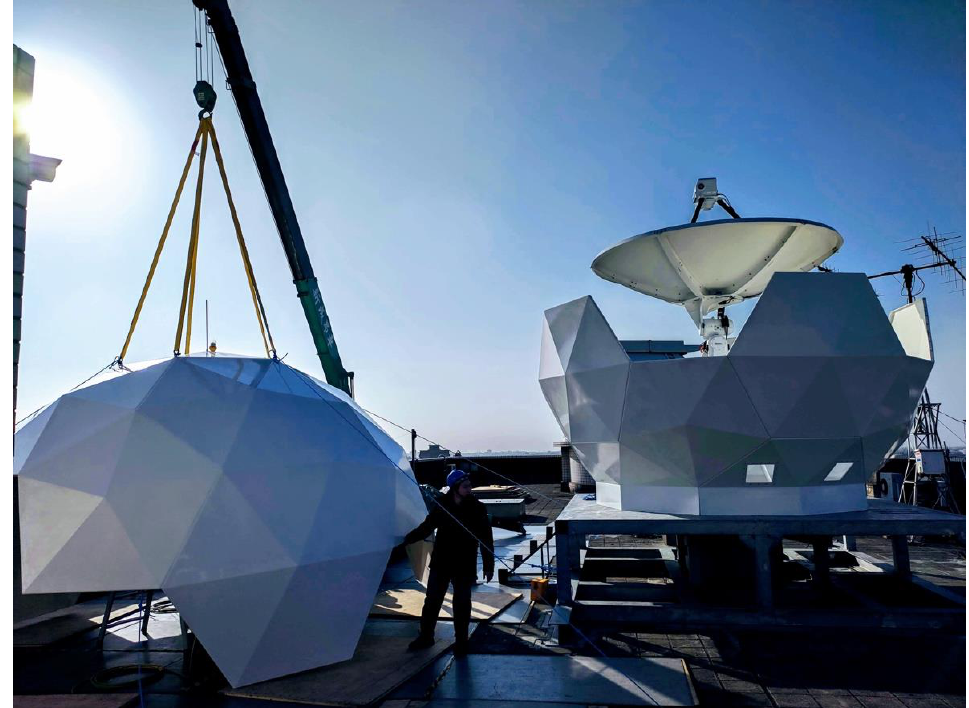
Figure 7. Construction of the NCU S-band ground station prior to full enclosure of the parabolic dish antenna by the radome. Note the construction worker in the lower center for scale, as well as the UHF and VHF cross-Yagi antennas and rotator partially obscured by the S-band ground station on the middle